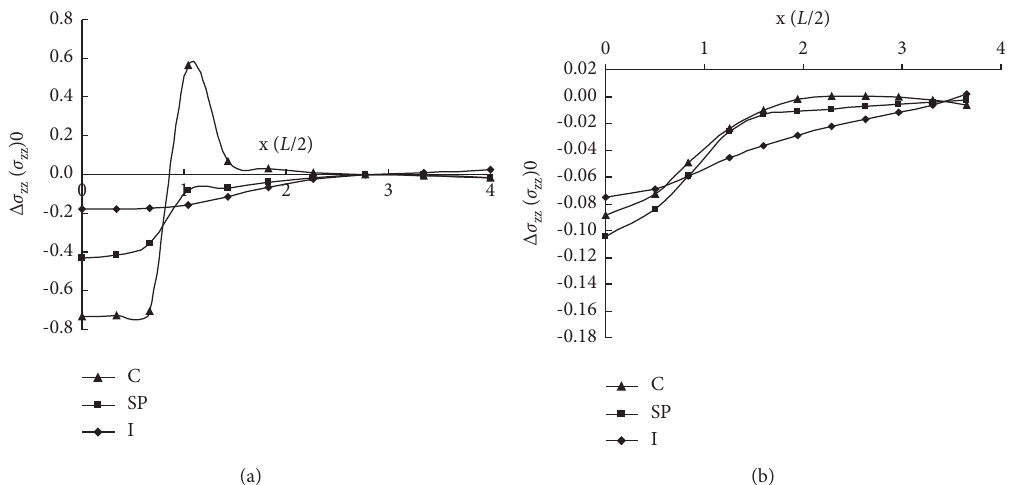
0 (%)) for case C and case S. (a) Case C. (b) Case S.